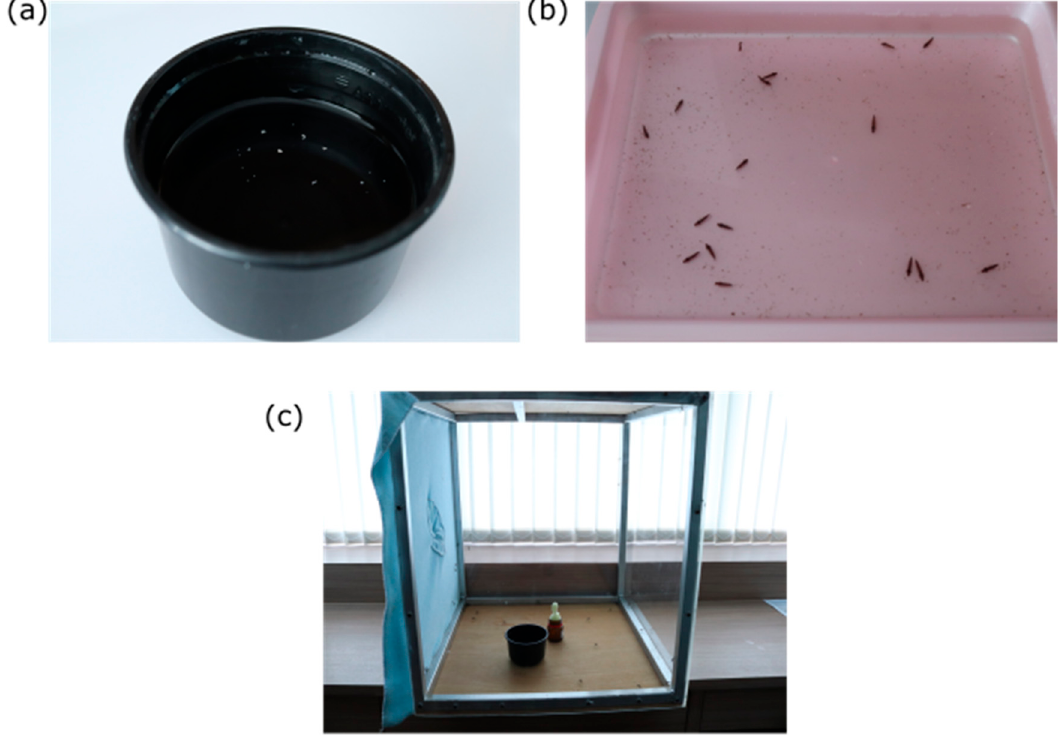
Figure 2. Standard Toxorhynchites -rearing containers for ( a ) eggs, ( b ) larvae and ( c )